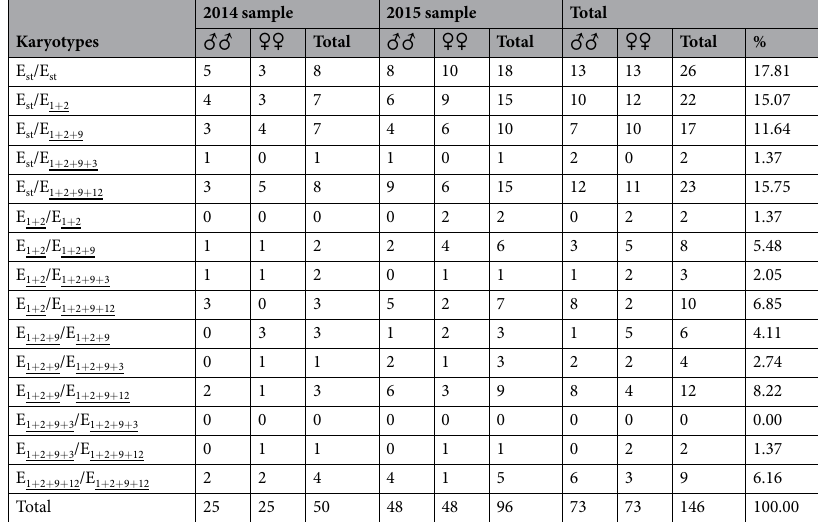
Table 2. Karyotype frequencies in samples from two consecutive years.